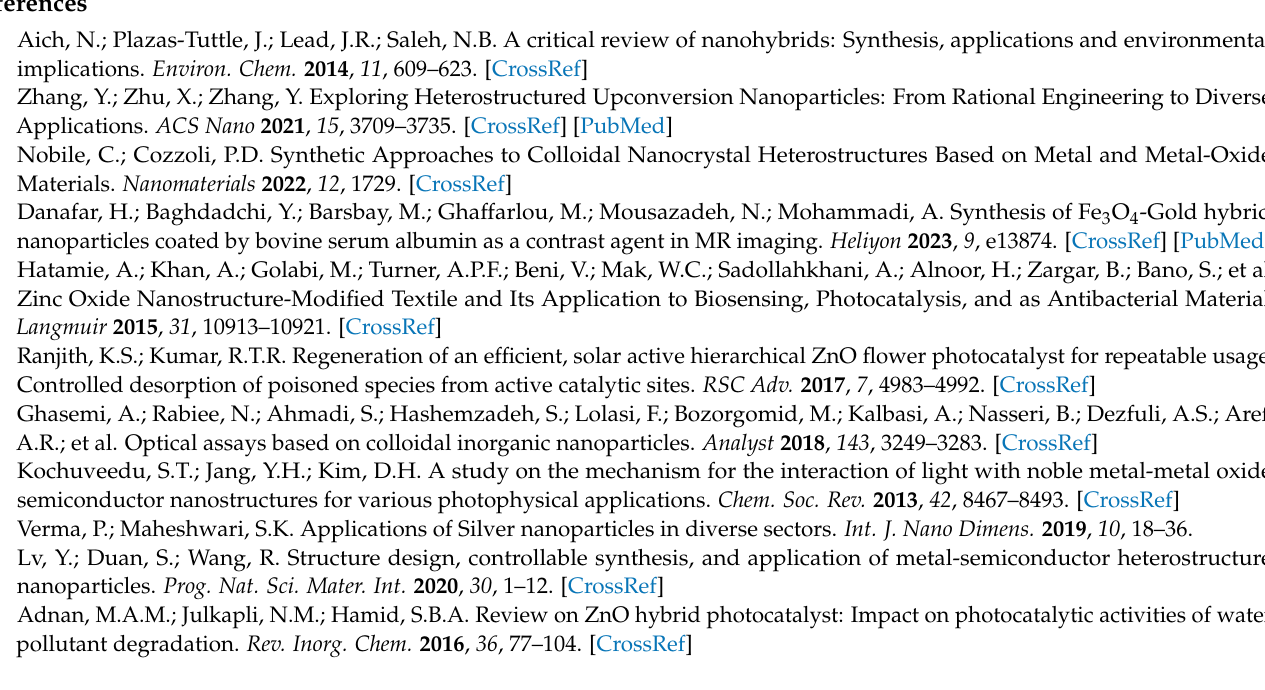
Figure S2. Test for the presence of gold cations in the products. Figure S3. Photoluminescence spectra of colloidal suspensions. Figure S4. UV-Vis spectra of reaction systems. Figure S5. FTIR spectra of samples. Figures S6–S9. The survey XPS spectra of heterodimers samples. Table S1. The